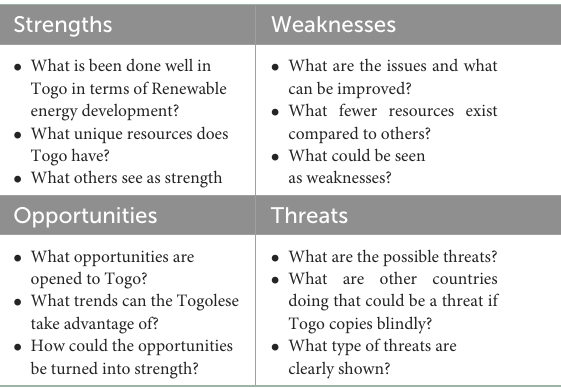
TABLE 2 SWOT analysis